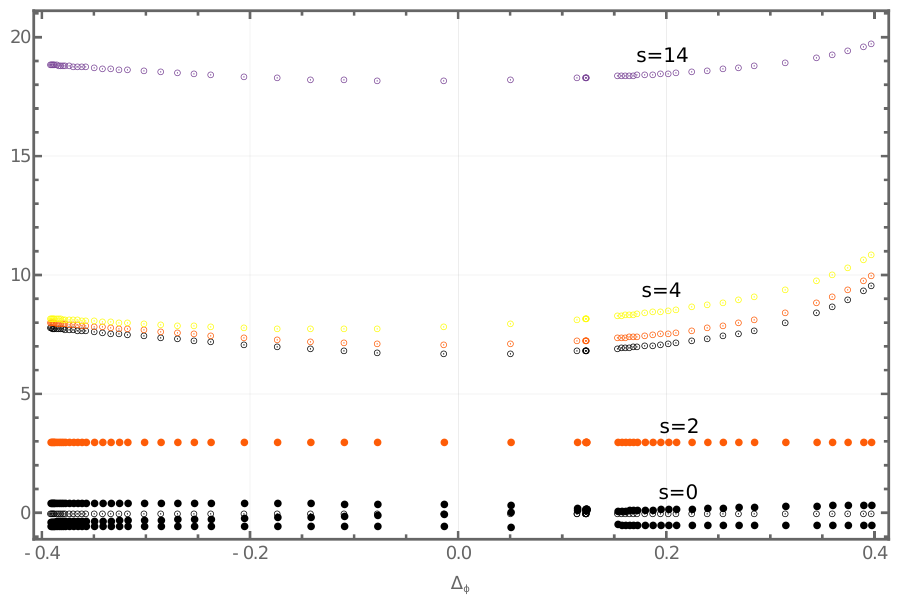
Figure 9 . Roots of the extremal functional in 3 dimensions evaluated at increasing values of ∆ φ . Single roots are denoted by filled circles and double roots are denoted by dotted